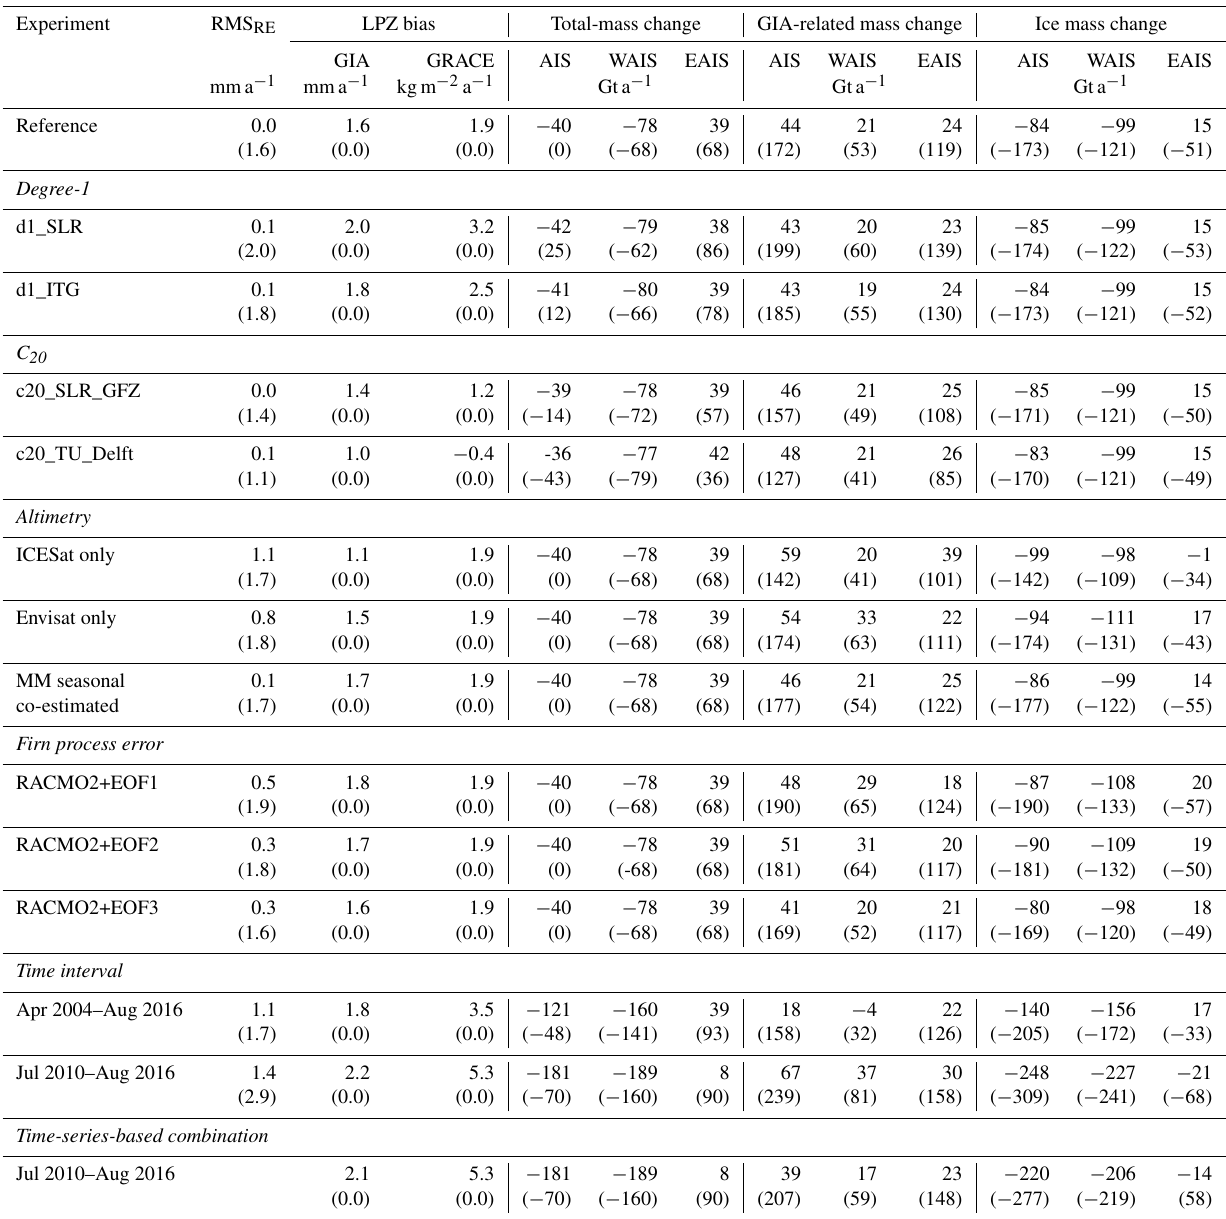
Table 2. Results from the sensitivity experiments. This table is structured like Table 2 in Gunter et al. (2014). Each line reports results from one experiment, where line one reports the reference experiment. The time period is March 2003–October 2009 except where it is quoted by experiment name. Column 1: experiment name, according to Table 1. Column 2: rms difference of the GIA-induced bedrock elevation change (BEC) estimate (RMS RE ) to the reference experiment. Columns 3 and 4: applied LPZ-based bias correction (see Sect. 2.2) for GIA-induced BEC and GRACE area density change, respectively. Columns 5, 6, and 7: spatial integral of total-mass change (Eq. 14) over the Antarctic Ice Sheet (AIS), the West Antarctic Ice Sheet (AIS), and the East Antarctic Ice Sheet (EAIS), including a 400km buffer zone. Columns 8–10 and 11–13: same as columns 5–7, but for the GIA-related mass change (Eq. 13) and for the ice mass change (Eq. 15), respectively. Numbers in brackets give results of experiments with no bias